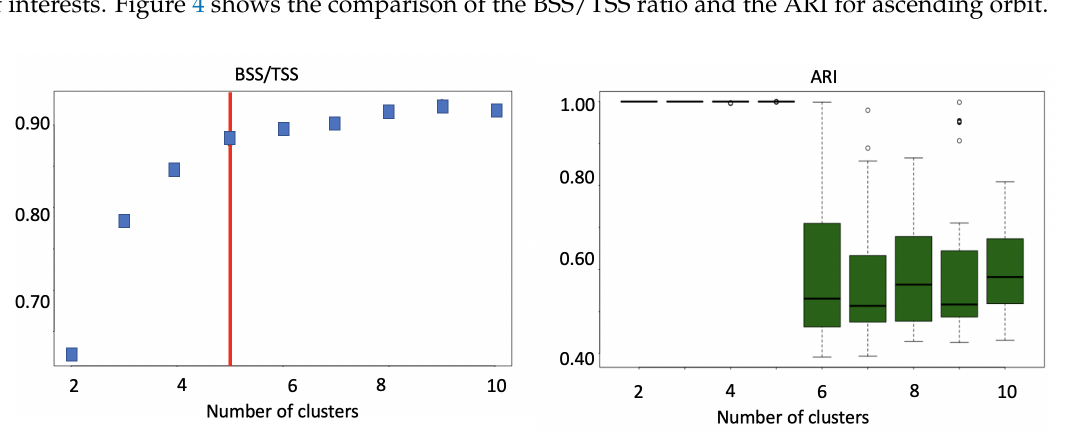
Figure 4. The BSS/TSS ratio (on left) reaches a plateau for a number of clusters k ≥ 5; the ARI values show that a perfect separation ARI (cid:39) 1 is obtained with k ≤